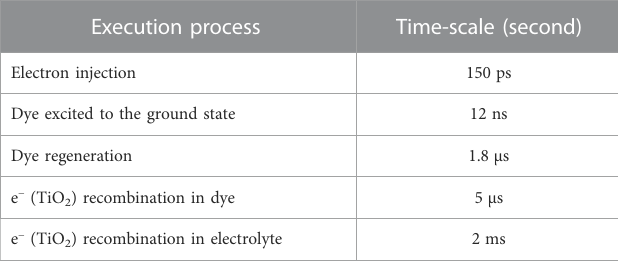
TABLE 3 Half-time-scale process in DSSC.